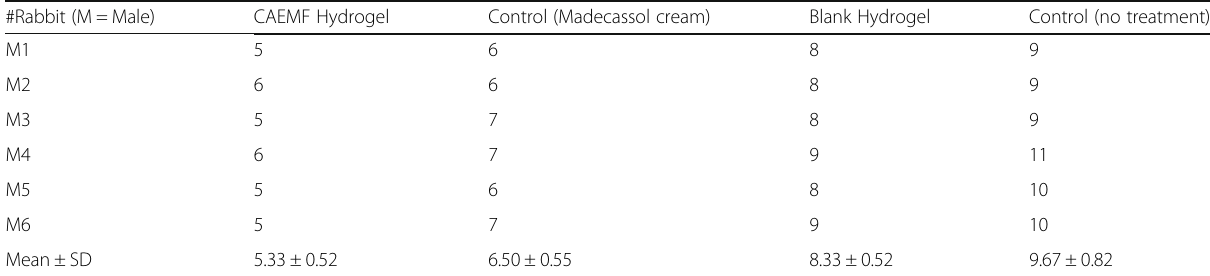
Table 1 Period of epithelization (Days)